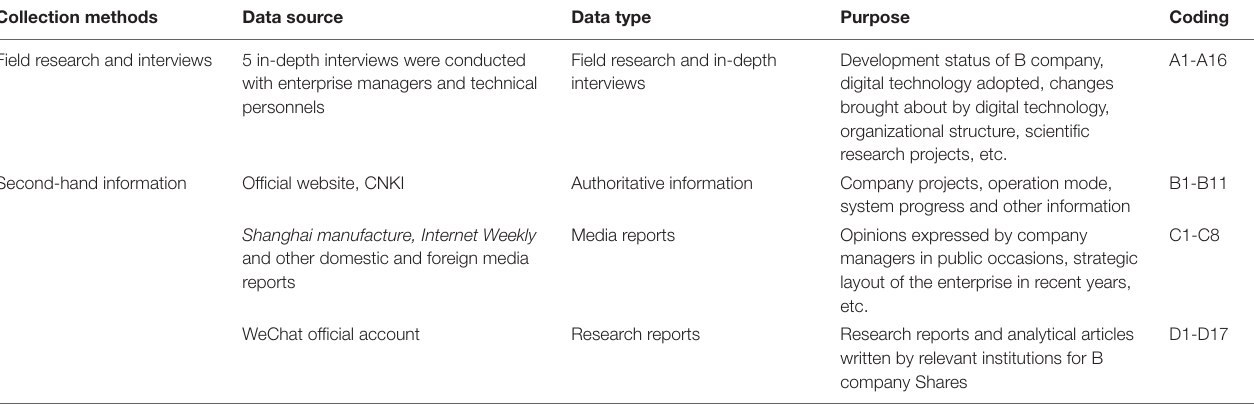
TABLE 1 | Data information and